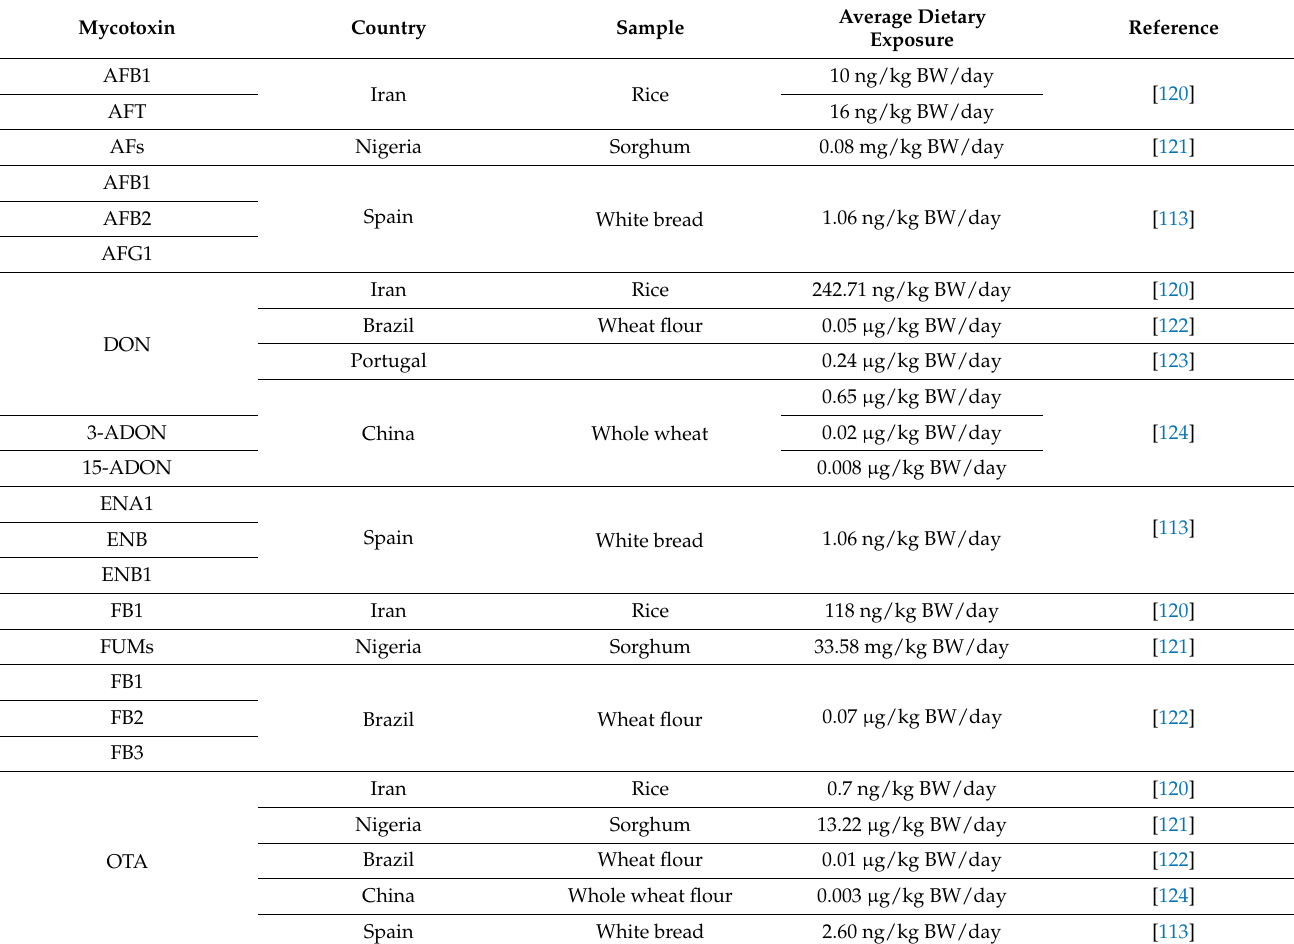
Table 4. Risk assessments of mycotoxin distribution in grain products depending on the